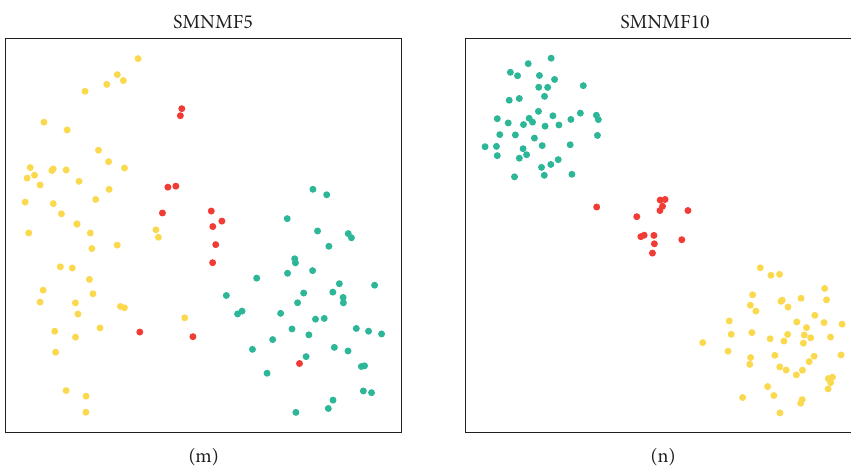
Figure 2: t -SNE 2D representations of different methods on